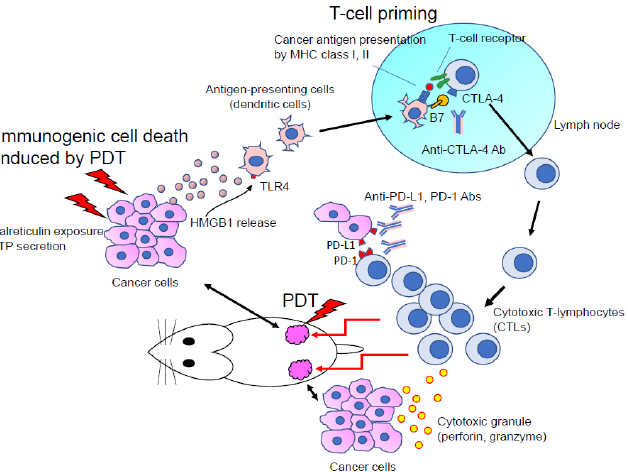
Figure 3. The synergistic effect of photodynamic therapy (PDT) and immune checkpoint blockade for anticancer effects. Immunogenic cell death (ICD) induced by PDT enhances the cancer antigen presentation by dendritic cells (DCs) through DC phagocytosis via calreticulin exposure, adeno- Scheme 1. (HMGB1) release. The enhancement of T cell priming results in antitumor effects facilitated by cytotoxic T lymphocytes (CTLs). Immune checkpoint blockade (anti-CTLA-4, anti-PD-1, anti-PD-L1 antibodies) synergistically enhance T cell priming and CTL’s attack against cancer cells.